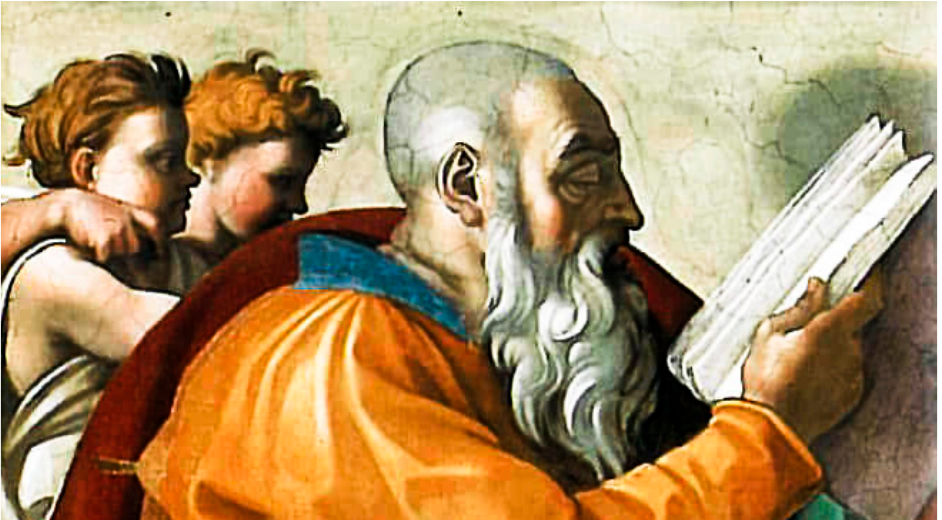
Figure 4. The Prophet Zechariah by Michelangelo in the Sistine Chapel. A close-up view of a section. Again, the hilarious example has been provided by Michelangelo in the Sistine Chapel ceiling. In the section devoted to the creation of the sun, the moon, and plants, on the right side, the classical figure of God springs up in the role of father with a long and grey beard. On the left side, God’s nape of the neck appears, as well as the soles of his feet, and his bare buttocks (juvenile?) through a gap in his purple robes. In other words, the rear end of the Absolute Being (Figure 5).